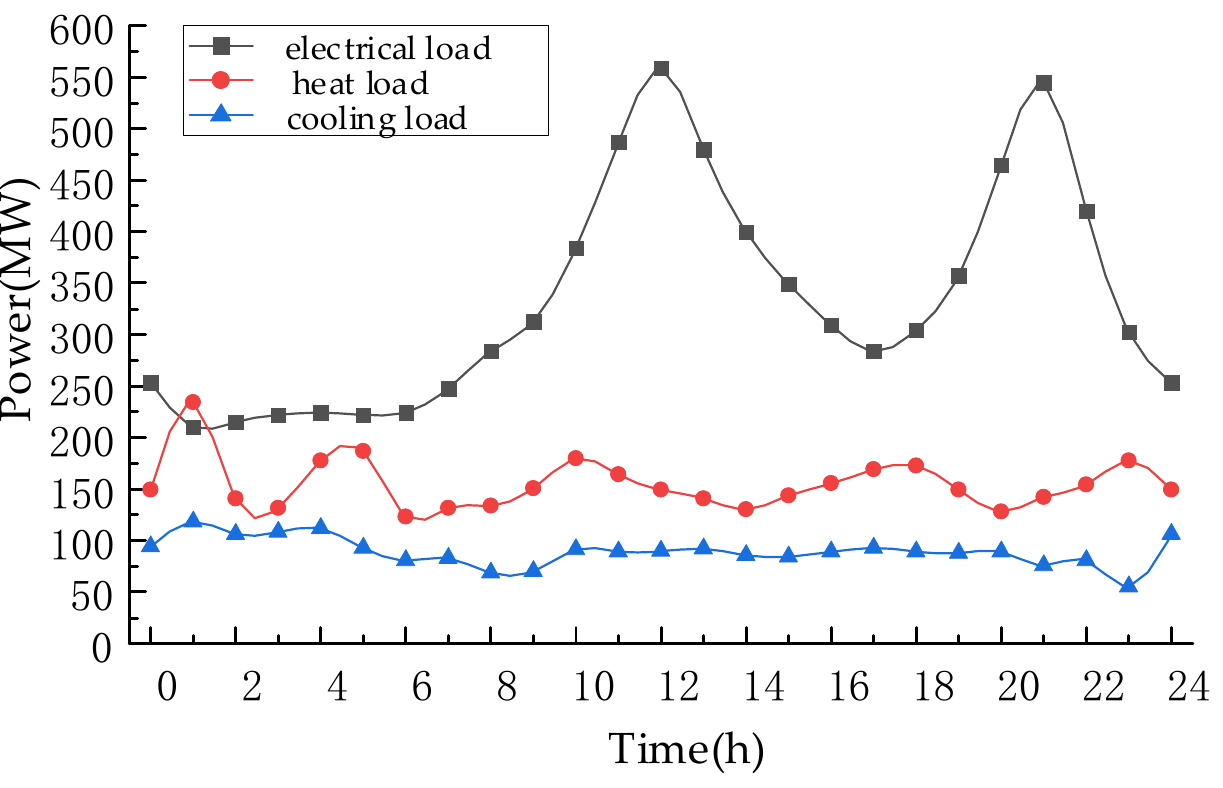
Figure 4. Typical daily load information.